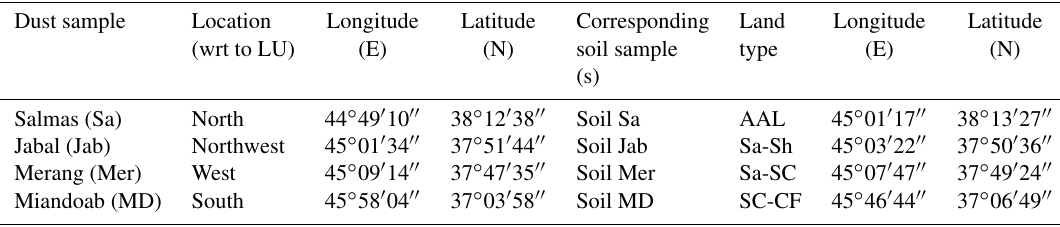
Table 1. The location of the collected dust samples and their corresponding soil samples. Dust sample Location Longitude Latitude